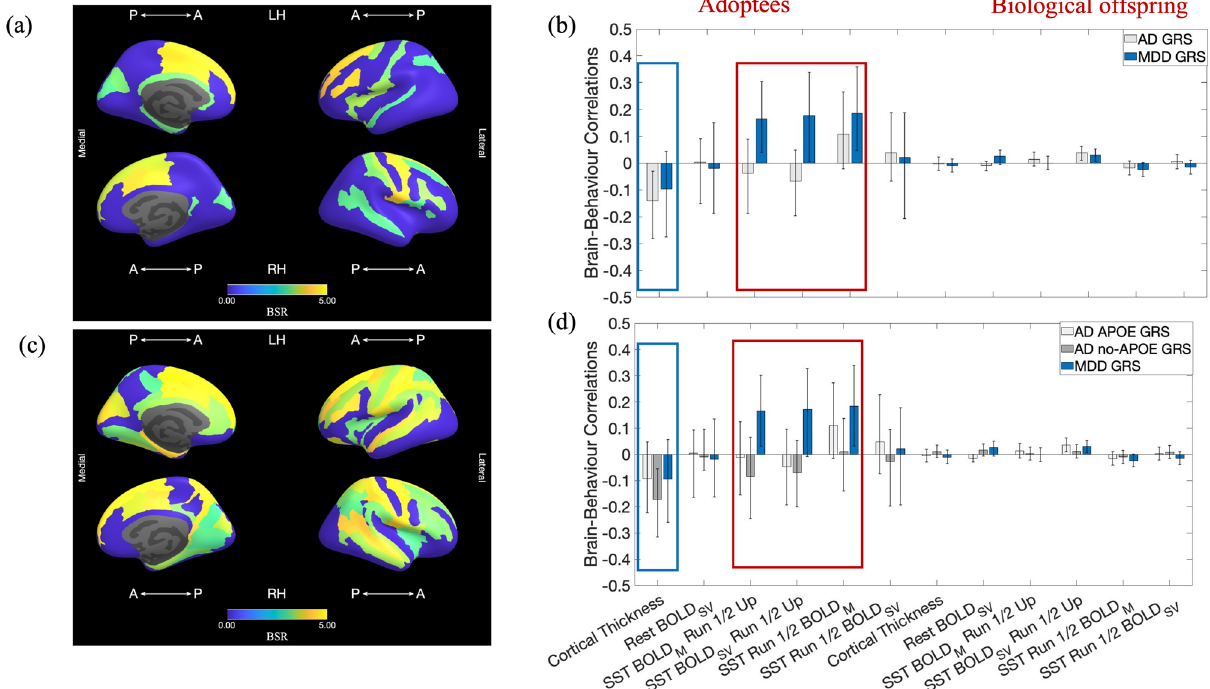
Figure 2. Results of the behavioural-PLS analyses. Panels ( b ) and ( d ) show the correlations between the LV brain scores and the GRSs. Error bars are the 95% CIs from the bootstrap procedure. CIs that do not include zero reflect robust correlations between the respective GRS and the brain score in a given condition (i.e., data type) across all participants. Panels ( a ) and ( c ) depict the Destrieux ROIs with robust loadings on the LVs in panels ( b ) and ( d ), respectively, and visualized with the Freesurfer Surface (https:// chris adams onmcri. github. io/ frees urfer_ stats urf_ displ ay). In the brain figures in panels ( a ) and ( c ), absolute BSR values lower than 3 have been set to zero. Rest BOLD SV = amplitude index of resting state low frequency fluctuations in BOLD signal. SST BOLD M Run 1/2 Up = difference between the GLM-derived run 2 and run 1 betas, based on the Correct Stop > Correct Go contrast. SST BOLD SV Run 1/2 Up = difference between the GLM-derived standard errors associated with the run 2 and run 1 beta, respectively, based on the Correct Stop > Correct Go contrast. SST Run 1/2 BOLD M = average of the GLM-derived run 2 and run 1 betas, based on the Correct Stop > Correct Go contrast. SST Run 1/2 BOLD SV = average of the GLM-derived standard errors associated with the run 2 and run 1 beta, respectively, based on the Correct Stop > Correct Go contrast. LV latent variable, CI confidence interval, LH left hemisphere, RH right hemisphere, AD Alzheimer’s Disease, APOE Apolipoprotein E, MDD Major Depressive Disorder, GRS genetic risk score, SST Stop-Signal Task, GLM general linear model, BOLD blood oxygenation level